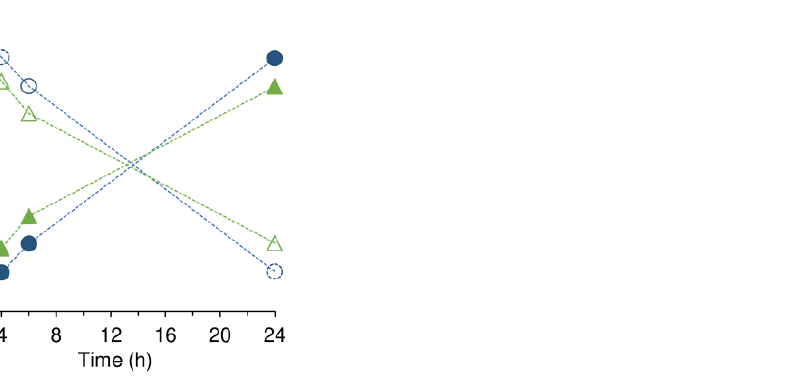
Figure 10. Selectivity of sulfoxides ( ○ , ∆ ) and sulfones ( ● , ▲ ) for reactions of MPS ( ○ , ● ) and DPS ( ∆ , ▲ ) as a function of time using 2 as catalyst and TBHP as oxidant, at 35 °C. Dashed lines are visual guides.